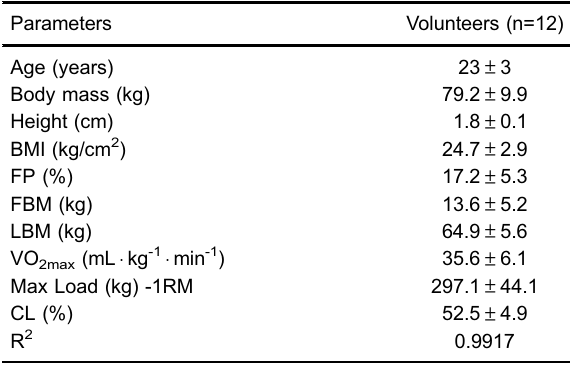
Table 1. Characteristics of the